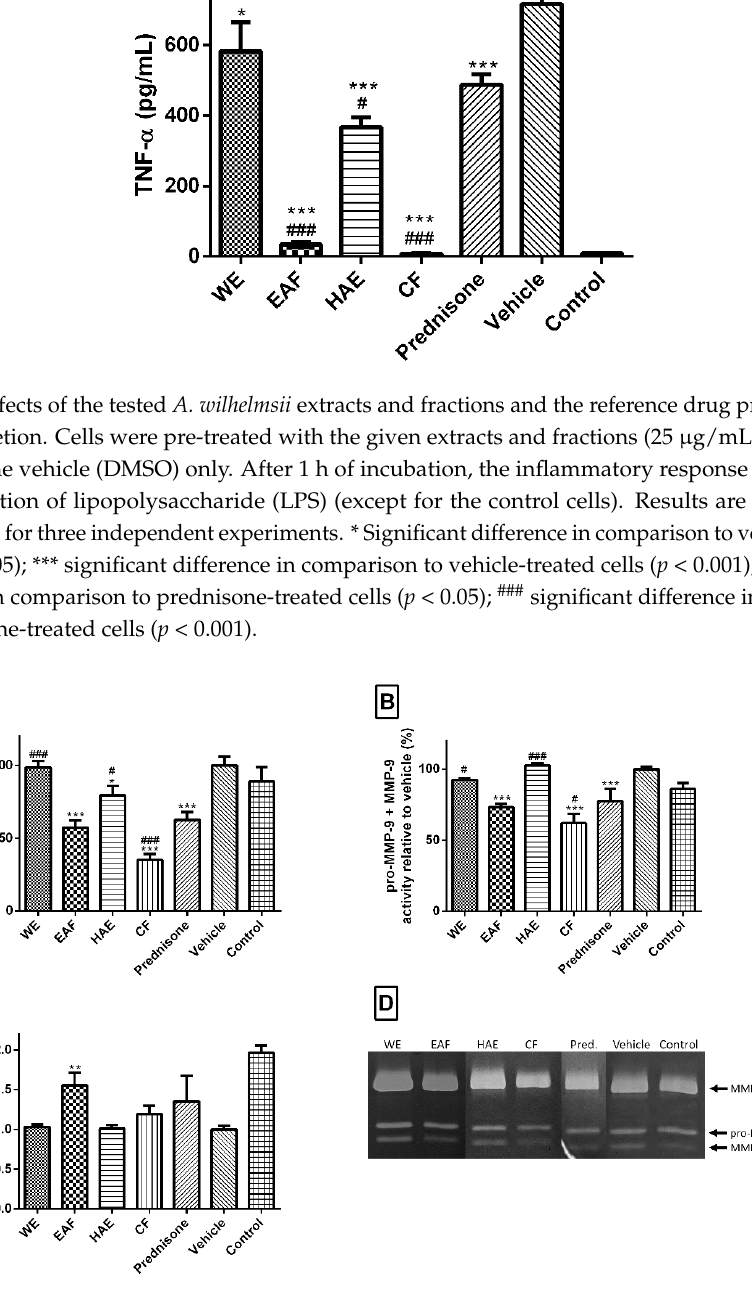
Figure 8. Effects of tested A. wilhelmsii extracts and fractions and the reference drug prednisone on LPS-induced matrix metalloproteinases (MMP) activity. Cells were pre-treated with given extracts (25 µg/mL), prednisone (1 µM; Pred.) or the vehicle (DMSO) only. After 1 h of incubation, the inflammatory response was induced by the addition of LPS (except for the control cells). The activities of MMP-2 ( A ) and MMP-9 ( B ) were detected by zymography. The intensity of the digested bands was analyzed by densitometry analysis; ( C ) The pro-MMP-2/MMP-2 ratio. The results are expressed as means ± SD for three independent experiments. * Significant difference in comparison to vehicle-treated cells ( p < 0.05); ** significant difference in comparison to vehicle-treated cells ( p < 0.01); *** significant difference in comparison to the vehicle-treated cells ( p < 0.001); # significant difference in comparison to prednisone-treated cells ( p < 0.05); ### significant difference in comparison to prednisone-treated cells ( p < 0.001); ( D ) The gel representative results of one of the three independent experiments.